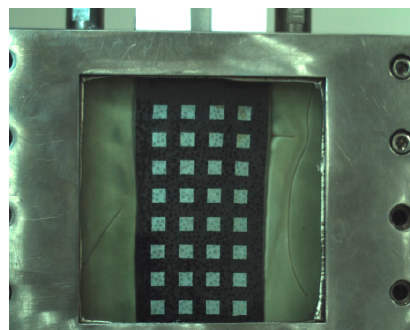
Figure 14. Glass bead sample in plane strain test.